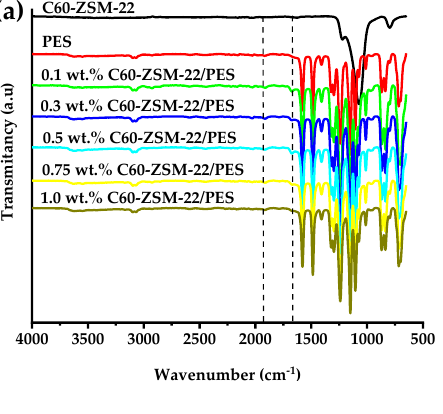
Figure 2. ATR-FTIR spectra of nanofiltration membranes prepared through a phase inversion method to nominal wt.% loadings of 0, 0.1, 0.3, 0.5, 0.75, and 1.0 using ZSM-22: ( a ) C60-ZSM-22/PES and ( b ) F60-ZSM-22/PES with zeolite as additives.